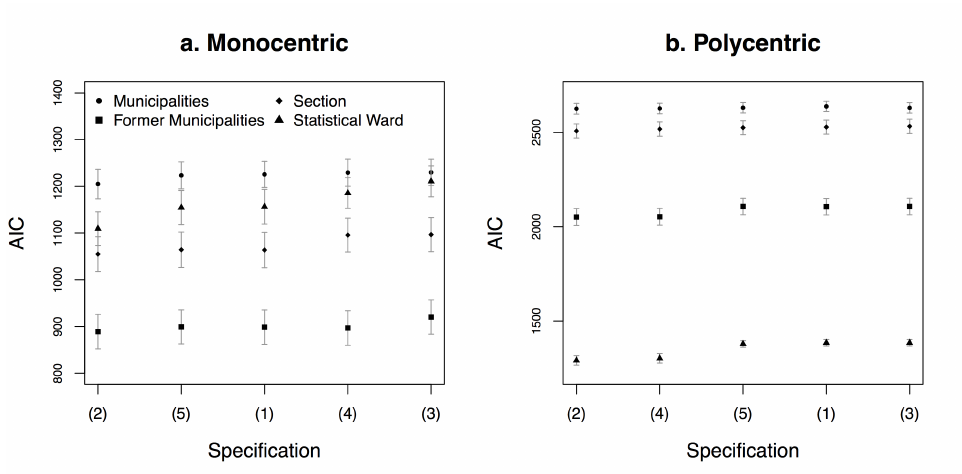
Figure 2: Variations of AIC through specifications (dots = AIC values, error bar = mean +/- 1 standard deviation; specifications are ordered by increasing value of AIC at the Statistical wards